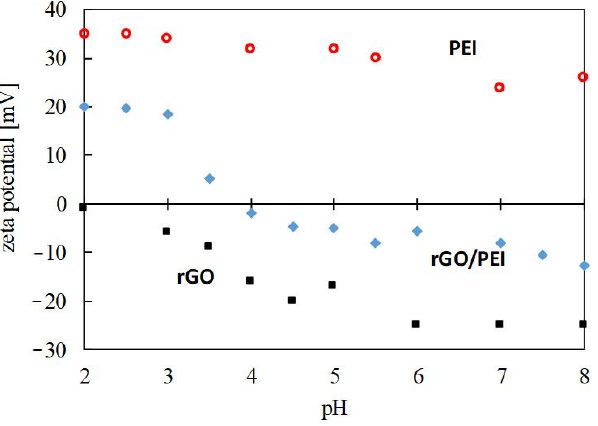
Figure 4. The zeta potential values measured for the studied sorbents in water as a function of pH. On the basis of the surface charge analysis, the deduced possible interactions be- tween the Hg(OH) 2 and rGO or rGO/PEI sorbents are shown in reactions (1–6) and sche- matized in Figure 5.